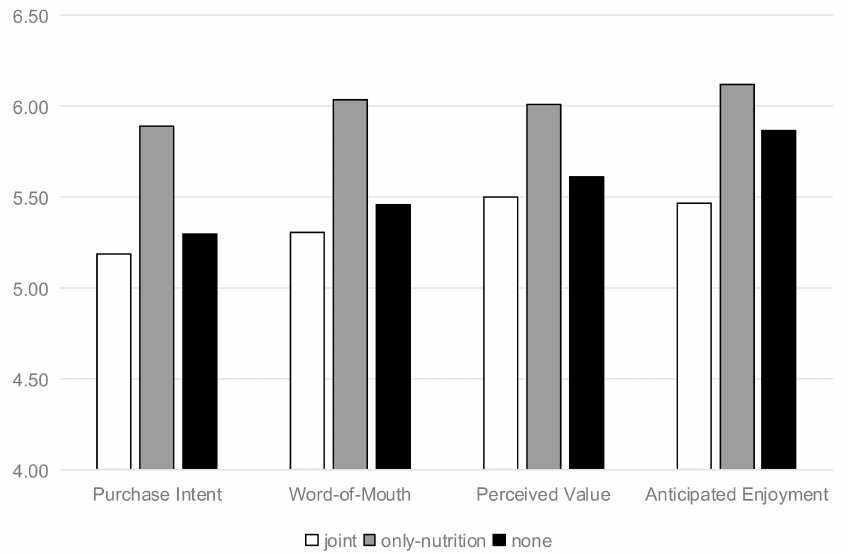
Figure 6. The backfire on the effect of cues on the purchase intention, word-of-mouth, perceived value, and mediators